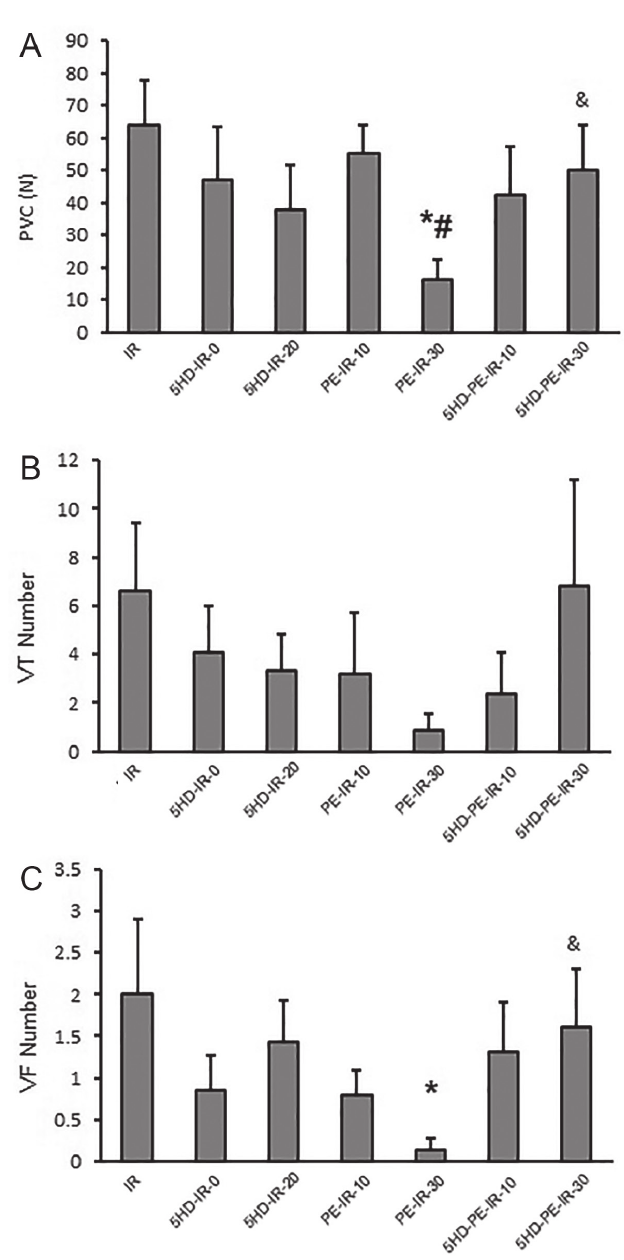
FIGURE 6 - A - episode number of PVC (premature ventricular contraction), B - episode number of VT (ventricular tachycardia) and C - VF (ventricular fibrilation) during 30 min ischemia in ischemia/reperfusion (IR), 5HD perfused at onset of regional ischemia (5HD-IR-0), 5HD perfused 20 min after regional ischemia (5HD-IR-20), phenylephrine- early perconditioning 10 min after ischemia (PE-IR-10), phenylephrine-late perconditioning 30 min after ischemia (PE-IR-30), 5HD-phenylephrine Early perconditioning (5HD- PE-IR-10), 5HD-phenylephrine-late perconditioning (5HD-PE- IR-30) groups. Data are presented as mean ± SEM. * P < 0.05 vs IR. # P < 0.05 vs. PE-IR-10 group. & P < 0.05 vs. PE-IR-30